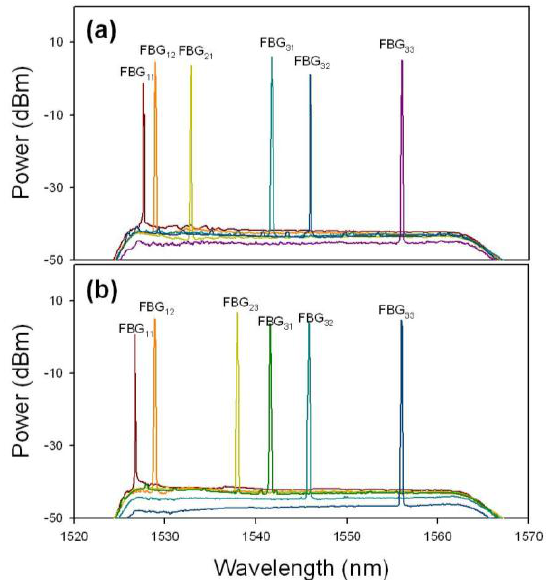
Figure 6. Measured output spectra of the sensing system via the (a) upper and (b) lower feeder fibers while a fault is on FBG 22